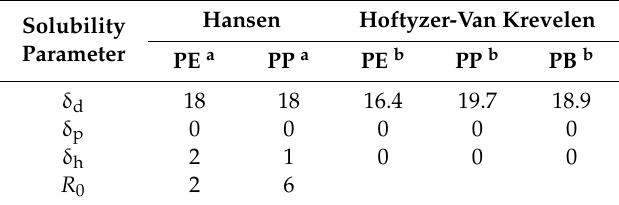
Table 3. Solubility parameters of Hansen and Hoftyzer-Van Krevelen group contribution methods. Solubility